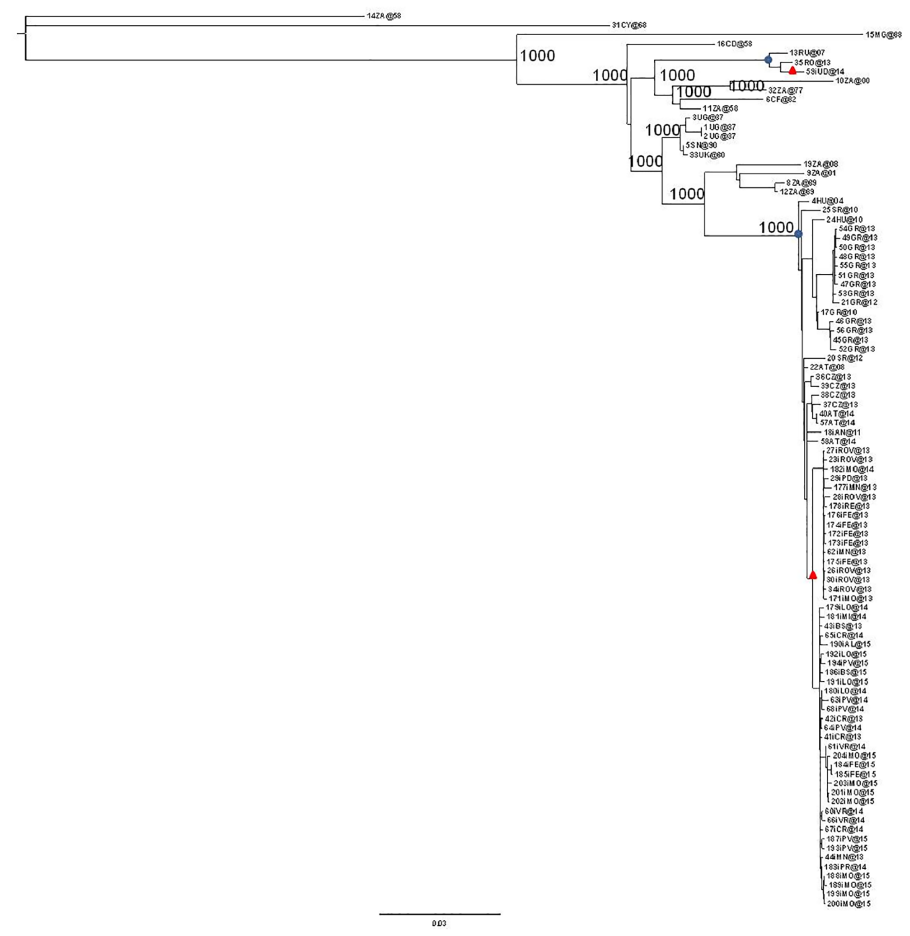
Fig 1. Maximum likelihood tree of the 97 West Nile virus complete genome sequences. The European clades have beenhighlighted(blue circles). The Italian clades are identifiedby red triangles. The scale bar indicates3% of nucleotide